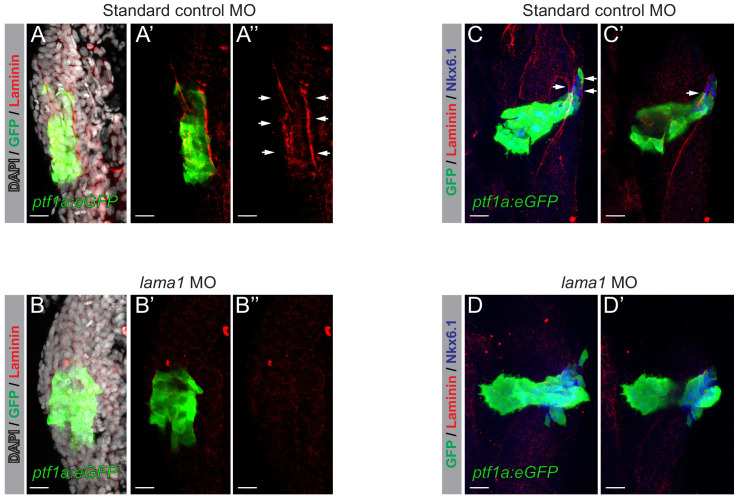
Validation of morpholinos targeting lama1.Confocal images (3D rendered) of 32–34 hpf Tg(ptf1a:eGFP)jh1 zebrafish foregut endoderm labeled with DAPI (nuclei, grey) and anti-Laminin antibodies (red). (A–A’’) Z-focal plane image of pancreatic progenitors marked by ptf1a:eGFP (green) and labeled with anti-Laminin antibodies (red) from embryos injected with non-targeting standard control morpholinos (n = 6). (B–B’’) Z-focal plane image showing loss of Laminin staining (red) in pancreatic progenitors marked by ptf1a:eGFP (green) from embryos injected with morpholinos targeting lama1 (n = 5/6). (C,D) 3D renderings of 45 hpf Tg(ptf1a:eGFP)jh1 zebrafish foregut endoderm labeled with antibodies against Nkx6.1 (blue) and Laminin (red). (C–C’’) Z-focal plane image of pancreatic progenitors marked by ptf1a:eGFP (green) and labeled with anti-Nkx6.1 (blue) and anti-Laminin (red) antibodies from embryos injected with standard control morpholinos (n = 4/4). (D–D’’) Z-focal plane image showing loss of Laminin staining (red) in pancreatic progenitors marked by ptf1:eGFP and labeled with anti-Nkx6.1 antibodies (blue) from embryos injected with morpholinos targeting lama1 (n = 3/4). Scale bar, 20 µM. Arrows highlight pancreatic progenitors marked by Laminin (red), Nkx6.1 (blue) and ptf1a:eGFP. MO, morpholino.